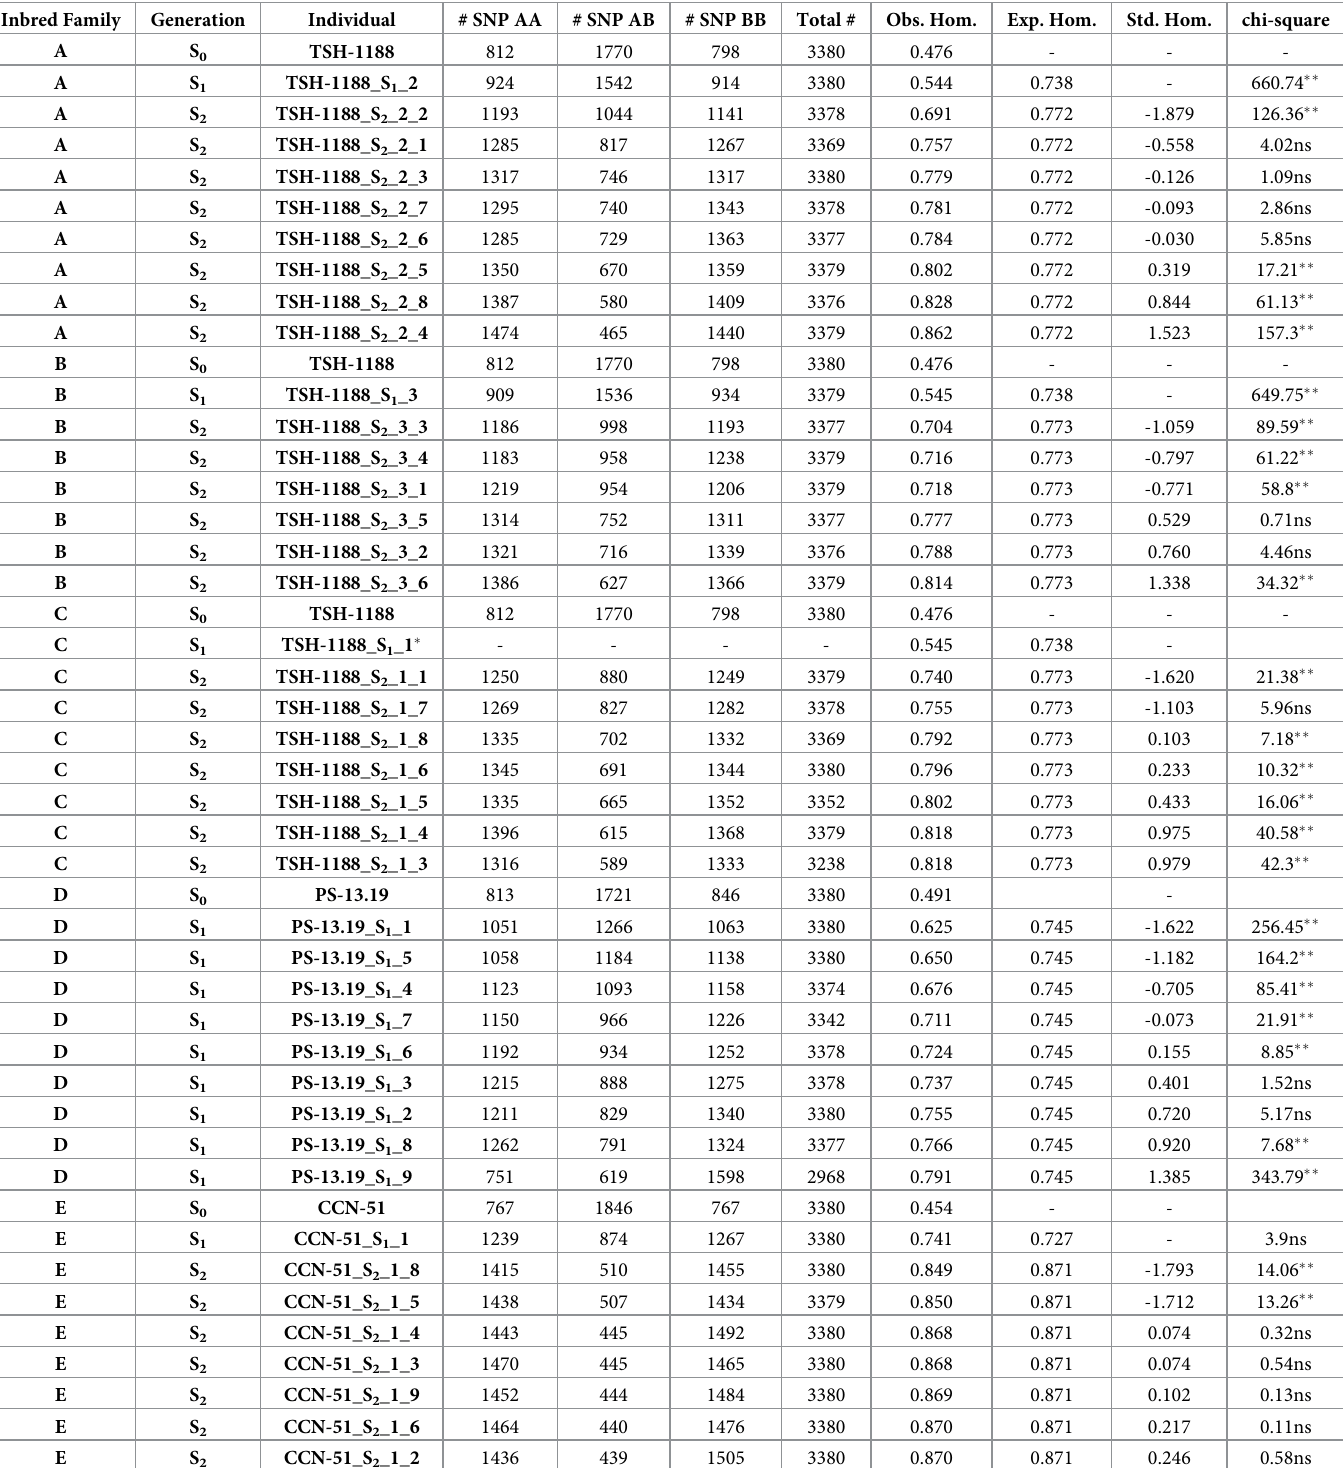
Table 1. Summary of the SNP genotyping data for the individual offsprings in the six inbred families produced by self-fertilization of four cacao clones indicated as